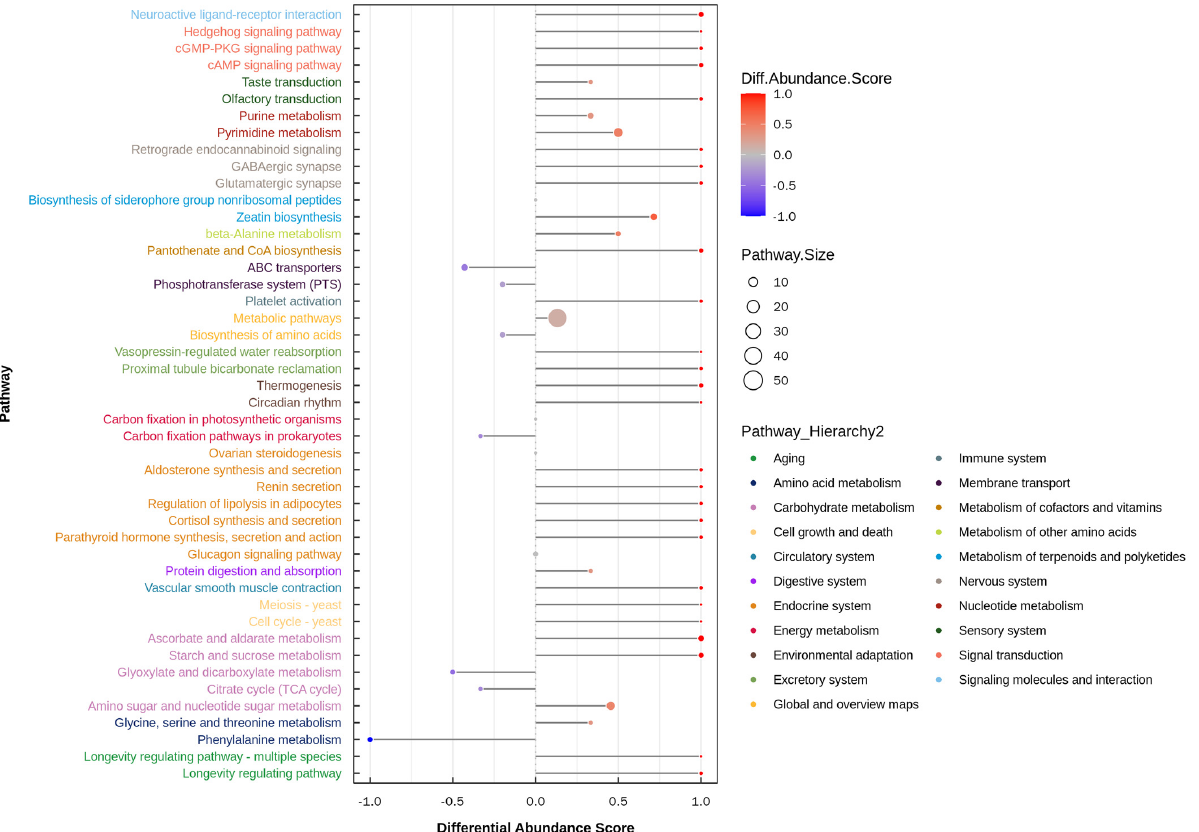
Figure 7. Differential abundance (DA) scores of all the enriched KEGG pathways. The Y -axis represented the name of metabolic pathway, and the X -axis represented the DA score. The DA score 1 indicated the up-regulated trend of all identified metabolites in this pathway, and − 1 indicated the down-regulated trend of all identified metabolites in this pathway. The length of the line segment represented the absolute value of the DA score, and the size of the dot at the end of the line segment represented the number of metabolites in the pathway. The dot color was proportional to the DA score.